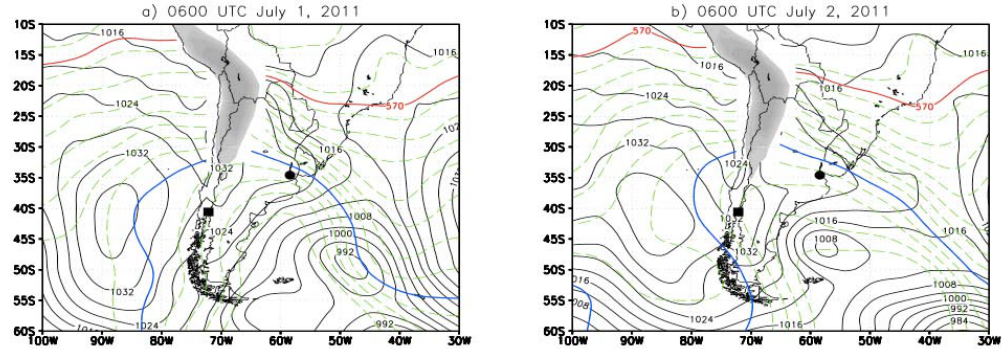
Fig. 2. Sea level pressure (in hPa, black contours) and 500/1000 thickness fields (in dam, green dotted contours) for 06:00UTC on (a) 1 July 2011 and (b) 2 July 2011. The blue line corresponds to 540dam and the red line to 570dam. The square indicates the location of the Puyehue volcano and the dot corresponds to the location of Buenos Aires. Terrain elevations greater than 1500m are shaded.